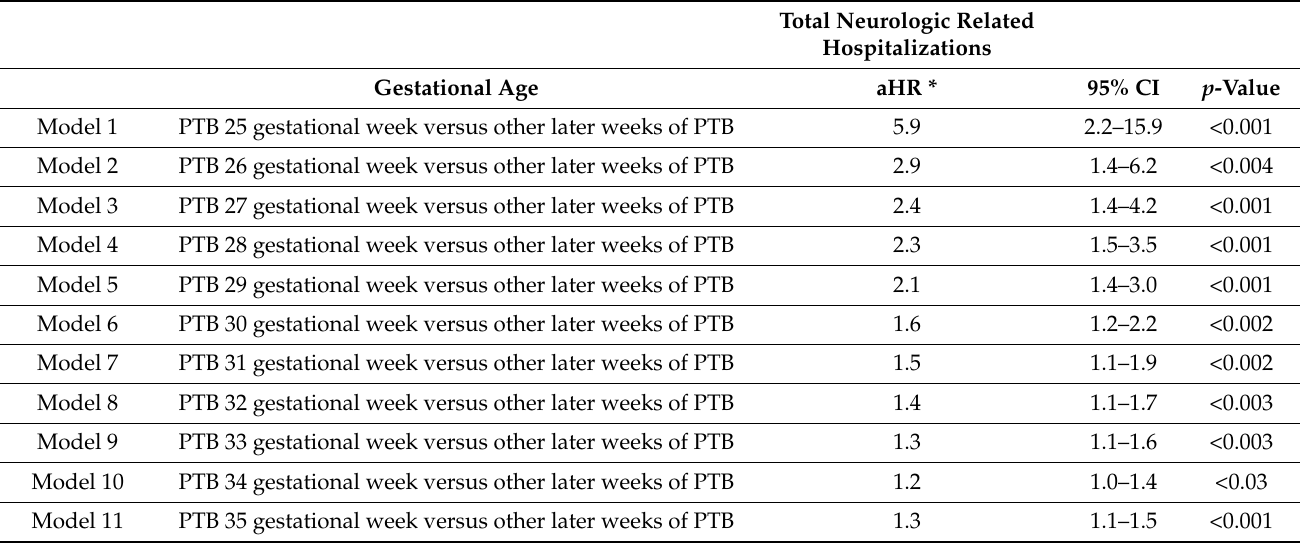
Table 4. Cox proportional hazards models for long-term neurological morbidity according to gestational age.